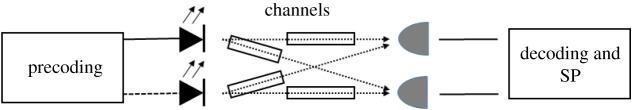
Typical diversity model.